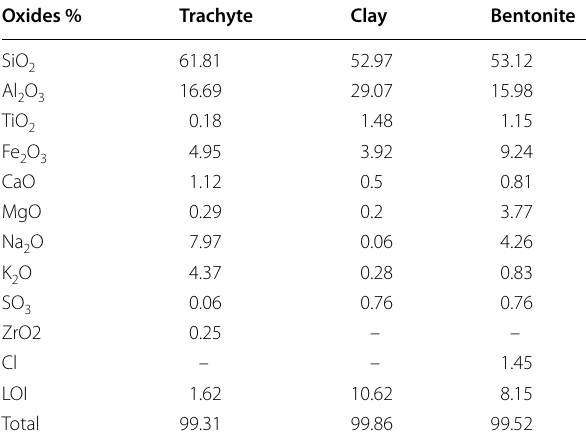
Table 1 Chemical composition of the used raw